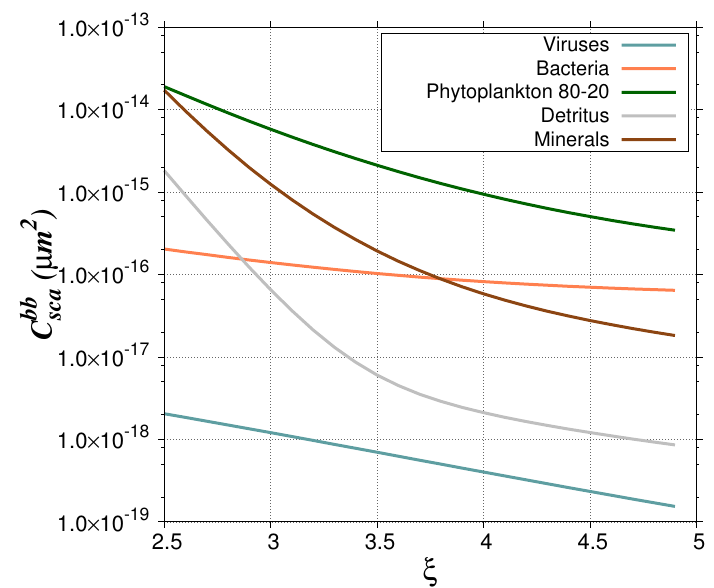
Figure 9. Backscattering cross sections, C bb sca , of the different particle groups. The phytoplankton cells are modeled as a two-layered sphere